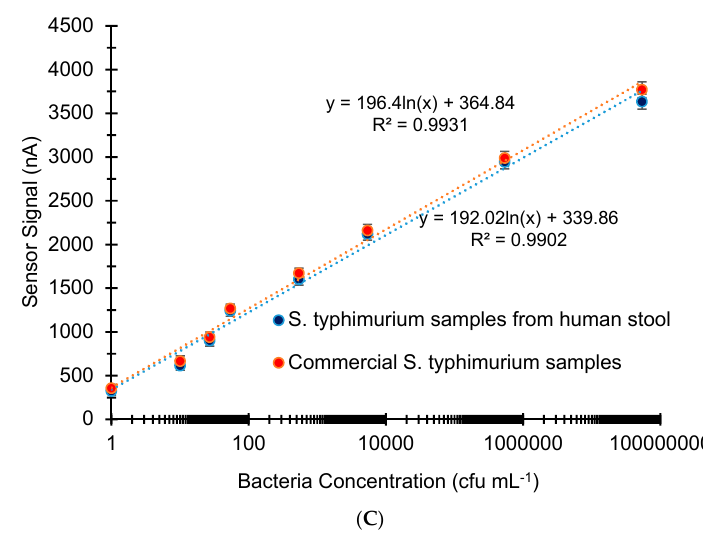
Figure 6. Real-time sensorgrams of commercial ( A ) and real S. typhimurium ( B ) detection in a concentration range of 1–5.41 × 10 7 cfu mL − 1 . Overall results of the AuNP-enhanced sandwich assays for the determination of commercial and real samples (n = 6) ( C ). CS: commercial sample, RS: real sample.